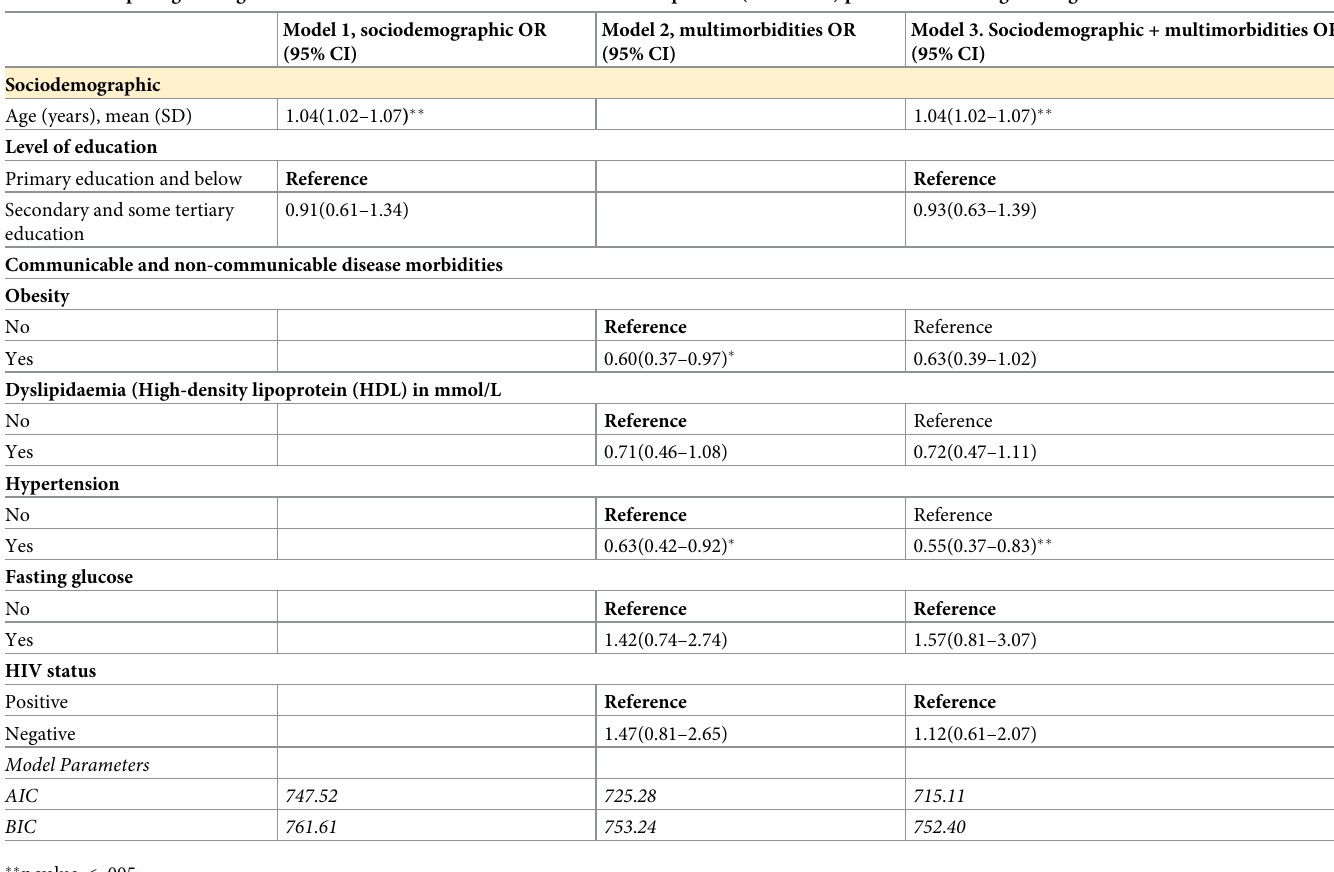
Table 6. Multiple logistic regression models of factors associated with bone scan positive (metastatic) prostate cancer stage at